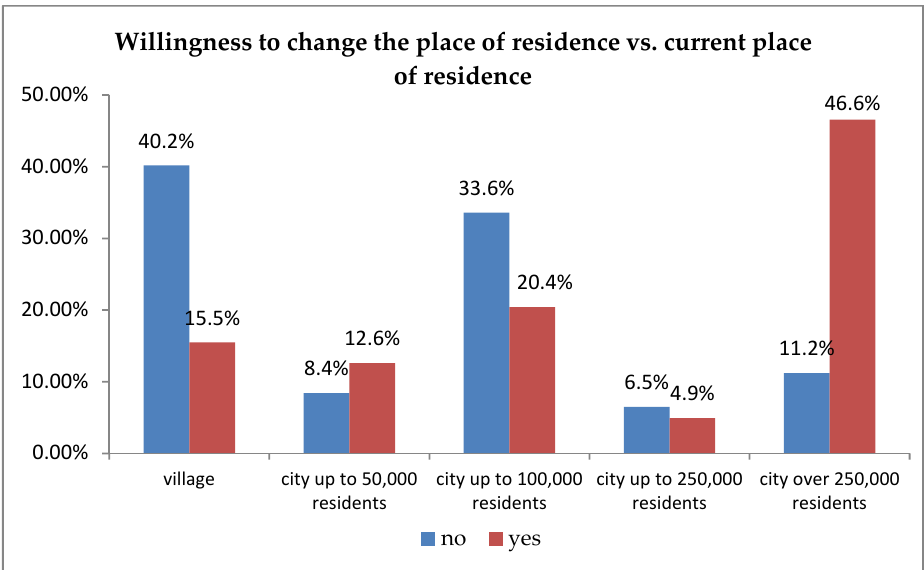
Figure 2. Willingness to change the place of residence in order to purchase (acquire) an apartment adapted to one’s mobility needs, free from architectural and technical barriers depending on the current place of residence.